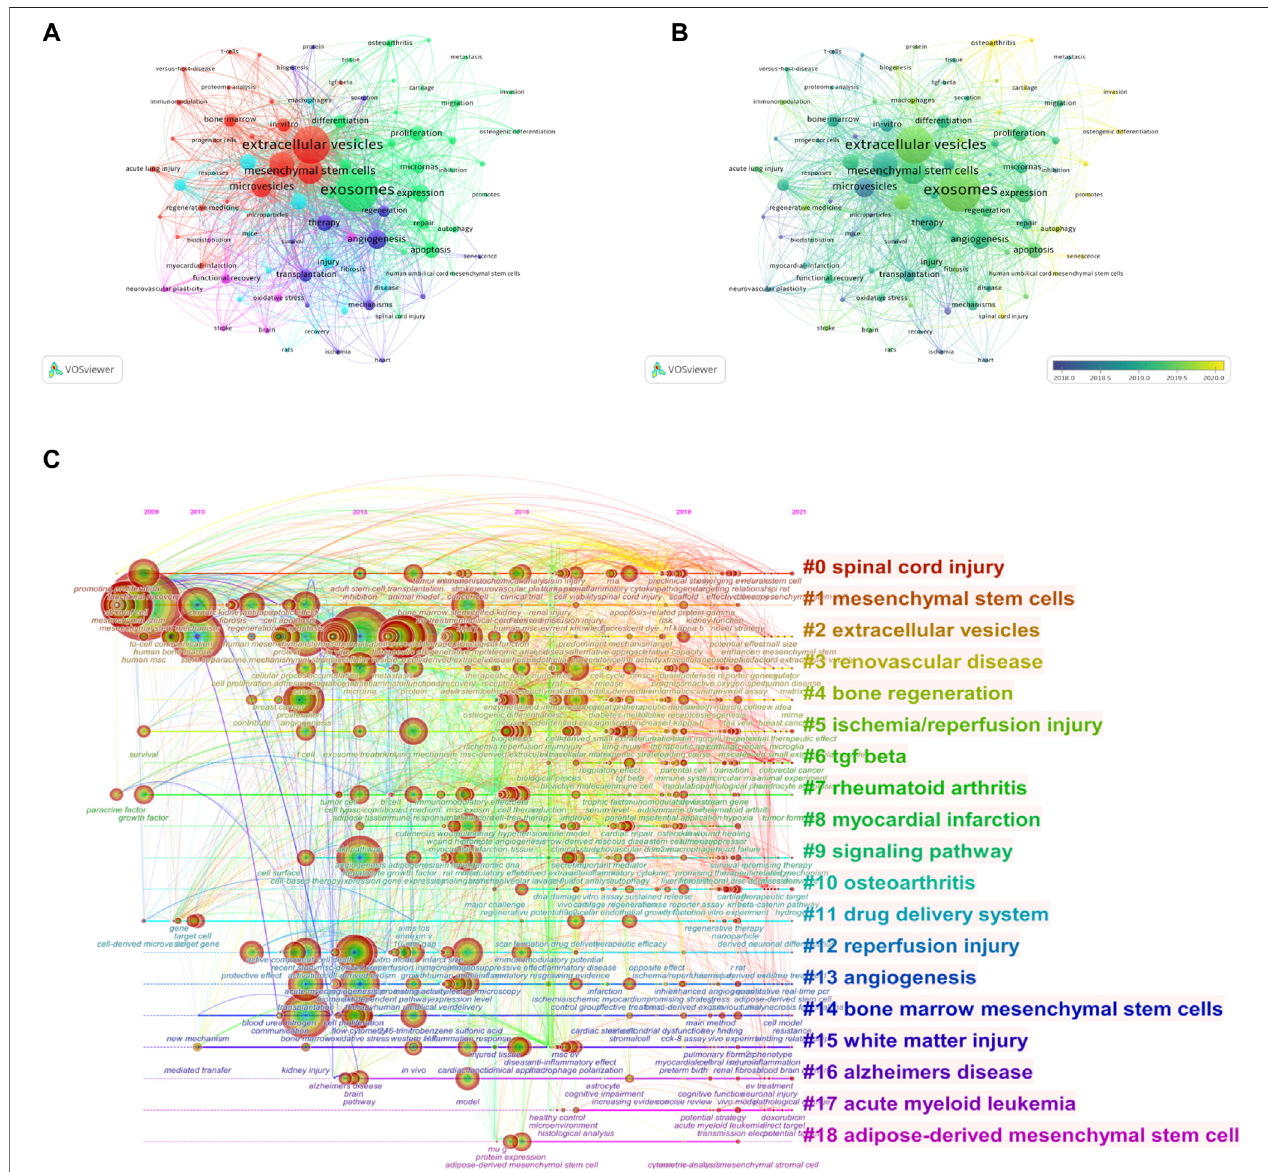
FIGURE 7 | Mapping of keywords in studies on MSC-EVs. (A) Network visualization of keywords. (B) Distribution of keywords according to average publication year (blue: earlier, yellow: later). (C) Keyword timeline visualization from 2009 to 2021.